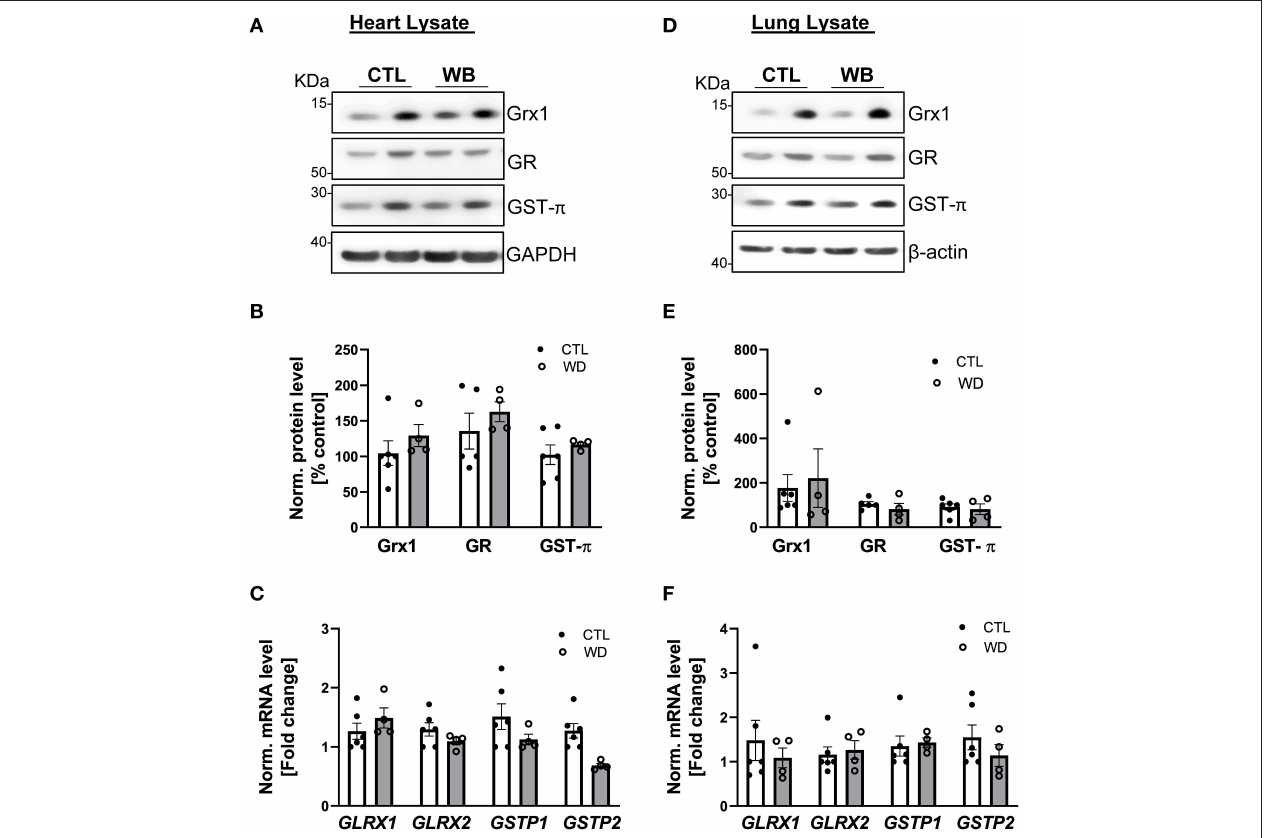
FIGURE 7 | In heart and lung tissue, Grx1, GR and GST- π levels were not significantly altered in weekend-binge ethanol-fed ApoE − / − mice compared with the control group. (A–C) Heart and (D–F) lung tissue homogenate from control (CTL) and weekend-binge (WB) ethanol-fed mice were assessed for the expression of Grx1, GR and GST- π . (A,B) Grx1, GR and GST- π protein level and (C) mRNA level of GLRX1, GLRX2, GSTP1 and GSTP2 was not altered in the heart tissue of the weekend-binge (WB) group as well as in the (D–F) lung tissue. (A,D) Representative immunoblot results and (B,E) densitometric analysis of Grx1, GR and GST- π in the tissue lysate. (C,F) mRNA results of GLRX1, GLRX2, GSTP1 and GSTP2 in the tissue lysate. Bars represent mean ratio ± error propagated S.E.M. ( n = 4–6, Student t